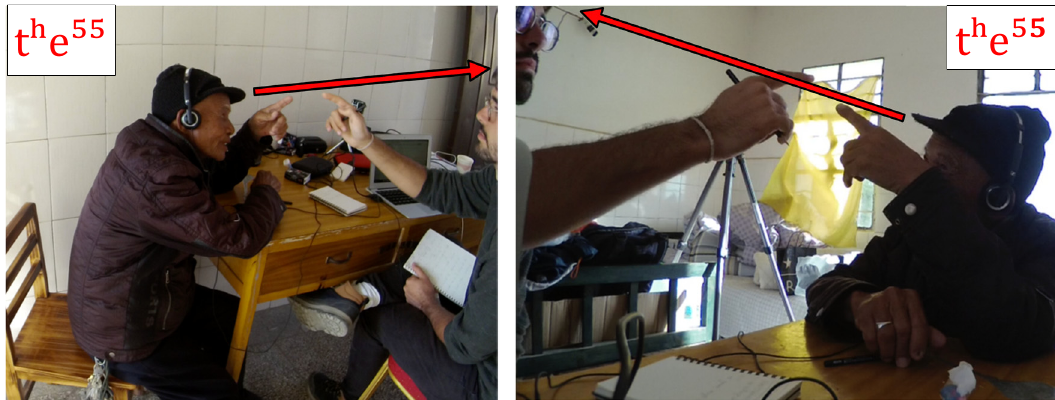
Figure 3: BLW points to his interlocutor ’ s hair. Co - timed with addressee deictic in Example 6. Same frame, di ff erent cameras.